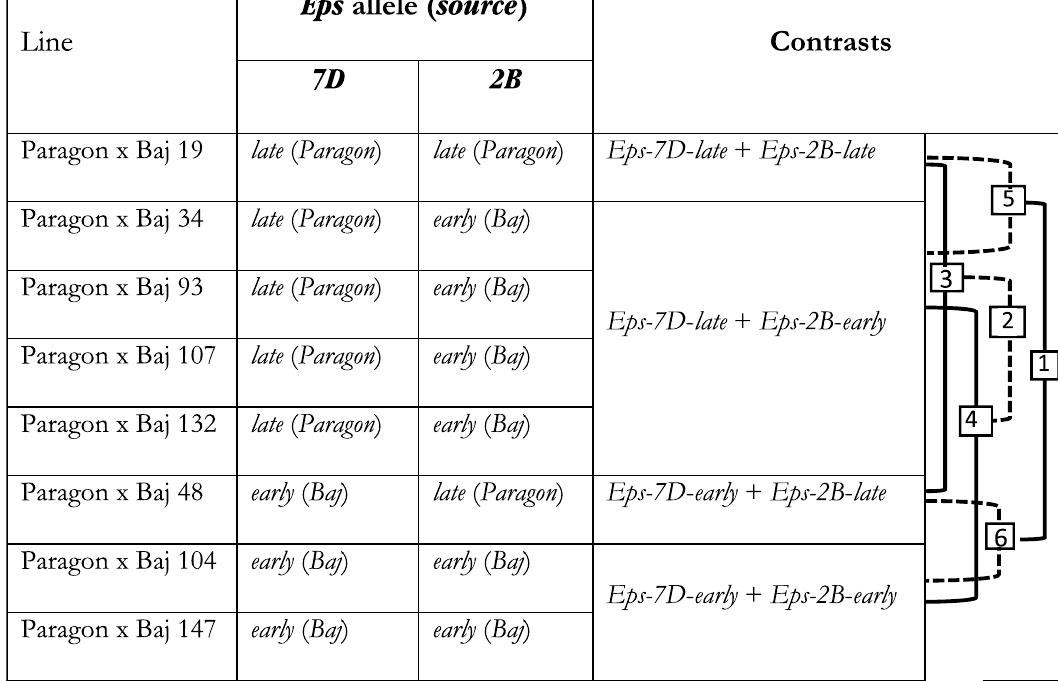
Table 2. Lines selected for this study, possessing contrasting alleles of both Eps genes ( Eps-7D and Eps-2B ). For comparing the effects of these alleles we averaged the results across lines possessing the same alleles of these two genes (see scheme for contrasts on the right and footnote). That offered four contrasting combinations of the two alleles ( late or early ) of the two Eps genes; and depending on the particular comparisons made the direct and interactive effects of these genes were studied. 1 and 2: direct effects of Eps -7D and Eps -2B genes, respectively. 3 and 4: effects of Eps -7D gene when the background has the late and early allele of Eps -2B gene, respectively. 5 and 6: effects of Eps -2B gene when the background has the late and early allele of Eps -7D gene, respectively.